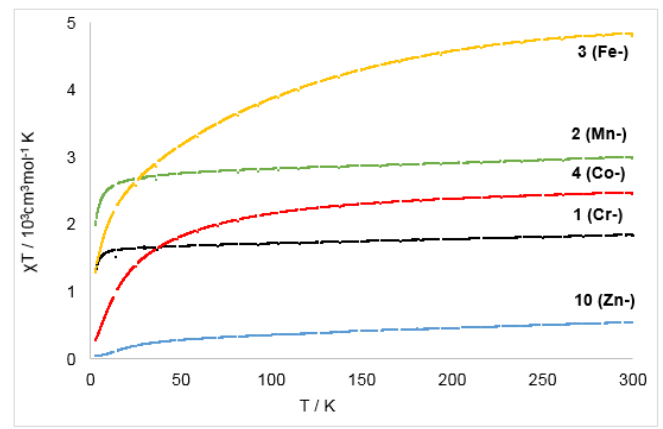
Figure 7. Temperature magnetic susceptibility ( χ T vs T) of the complexes 1 – 4 and 10 from 3 K to 300 K at 1 T. Table 5. Calculated Θ and χ TIM values for the anionic complexes 1 – 4 and 10 obtained from fitting of their variable temperature magnetic data to the Curie–Weiss